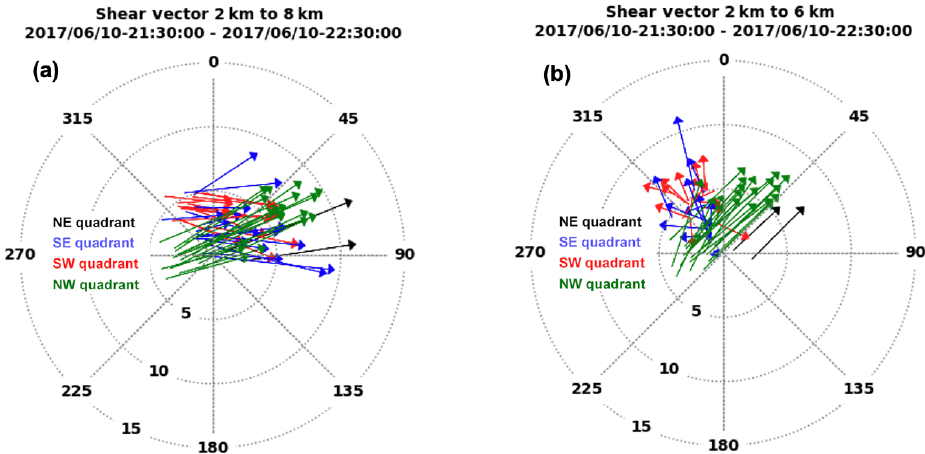
Figure 17. Same as Fig. 5, but for flight segment 4